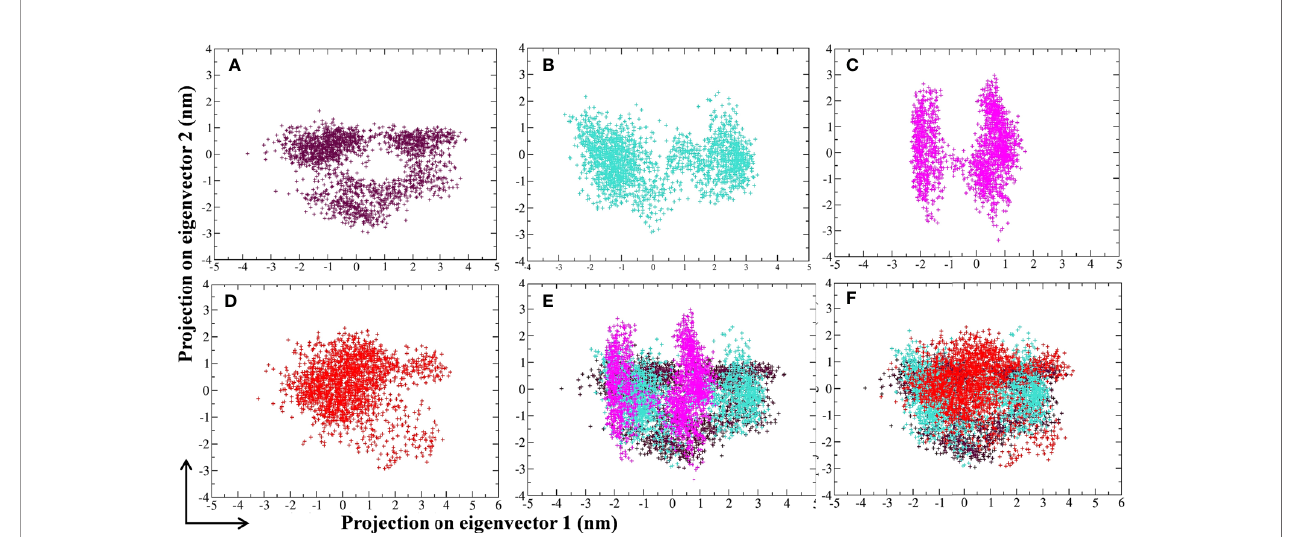
FIGURE 8 | Projection of SARS-CoV-2 M pro protein atoms in phase space along the fi rst two principal eigenvectors. (A) Unbound M pro protein. (B) Lopinavir-bound M pro complex, (C) Aloe vera lead compound 10-Hydroxyaloin A – bound M pro complex, (D) Neem lead compound Isoquercetin-bound M pro complex, (E) Unbound M pro and lopinavir/ Aloe vera lead compound – bound complex, (F) Unbound M pro and lopinavir/Neem lead compound – bound complex. Unbound protein, purple color; Aloe vera – bound complex, pink; Neem-bound complex, red; and Lopinavir-bound complex is shown in light-blue color.